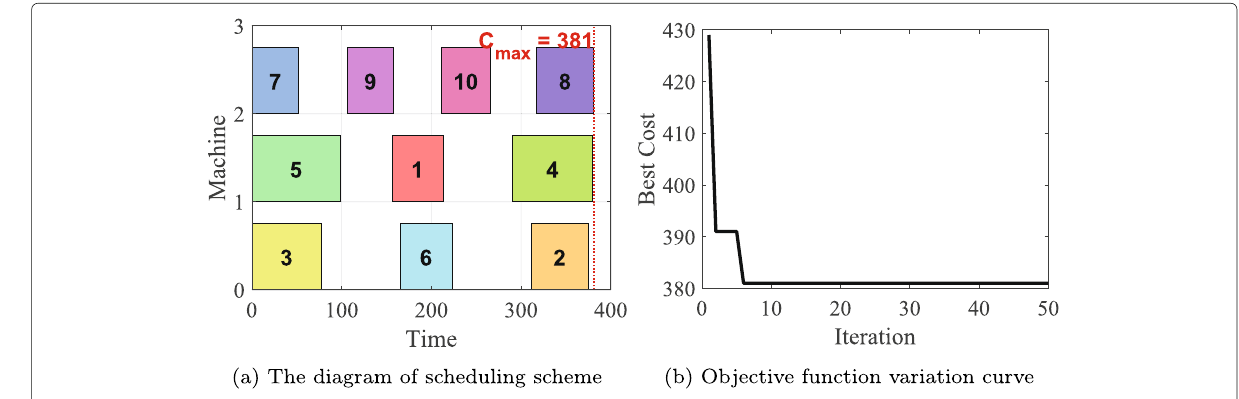
Fig. 2 IFACL solves the UPMSP problem through 50